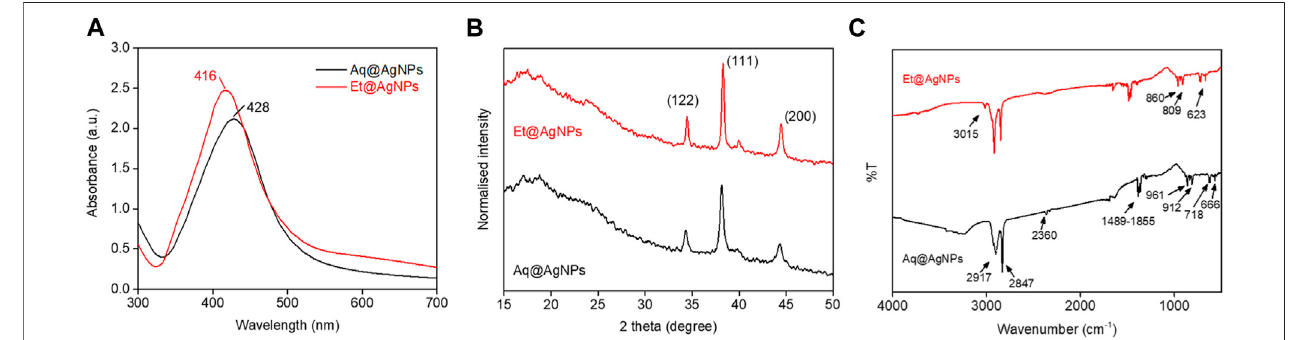
FIGURE1| Characterizationofas-preparedbiogenicAgNPs usingthe aqueous (Aq) andethanolic (Et)fruit extract of Diospyros malabarica . (A) UV-visible spectra of aqueous extract mediated AgNP (i.e., Aq@AgNPs) and ethanolic extract mediated AgNP (i.e., Et@AgNPs). (B) Crystallinity study of Aq@AgNPs and Et@AgNPs